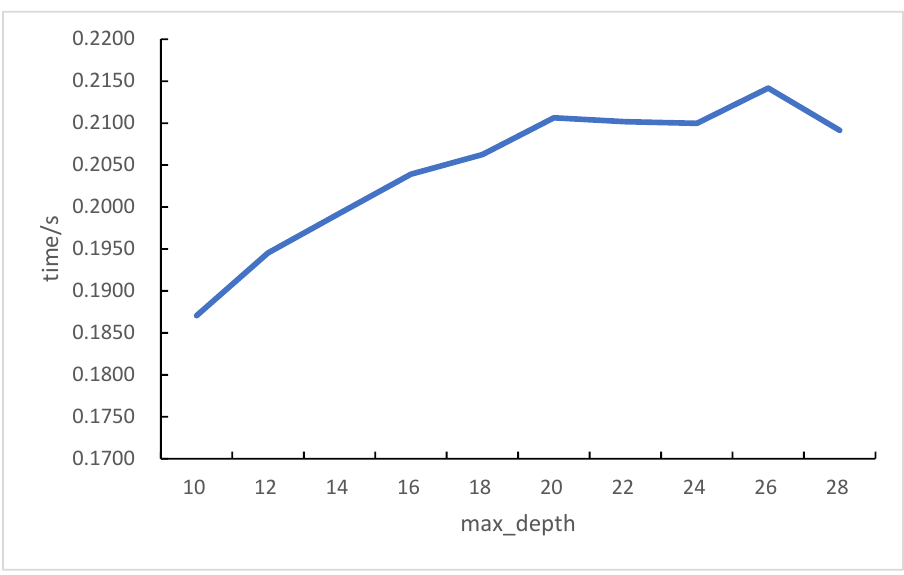
Figure 16. max_depth optimization predict_time.